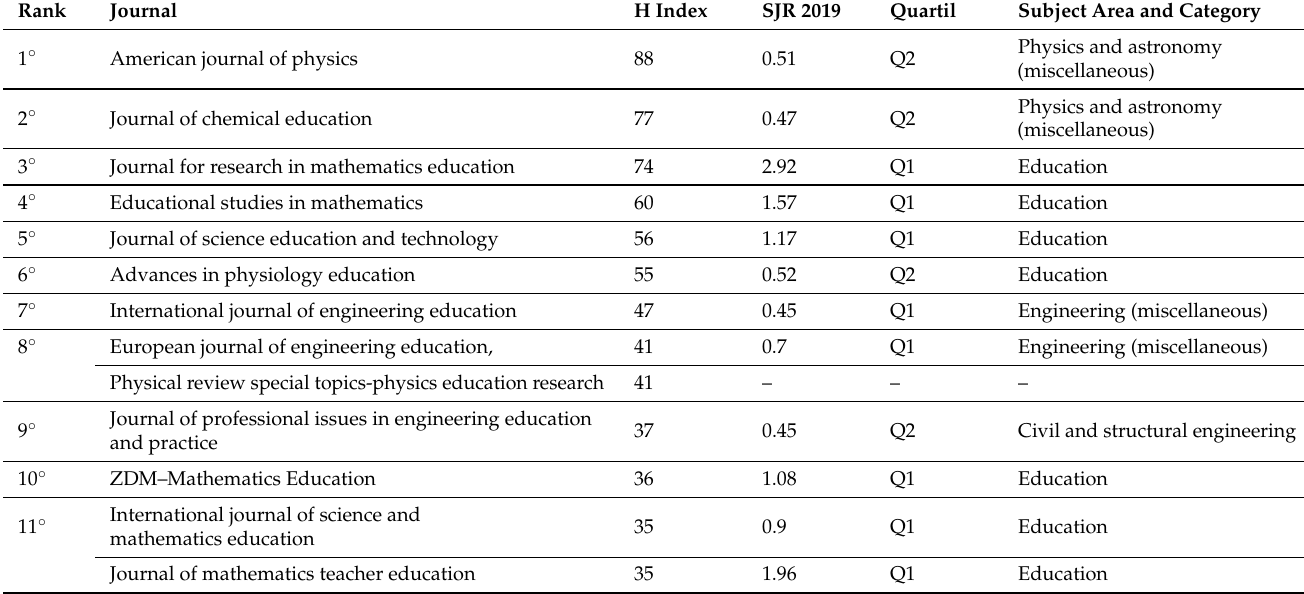
Table 3. The top 11 journals according the H index reported by Scimago Journal & Country Rank, where particularly there are 7 journals in the subject area of Education. The quartil and subject area of Physical review special topics is not assigned